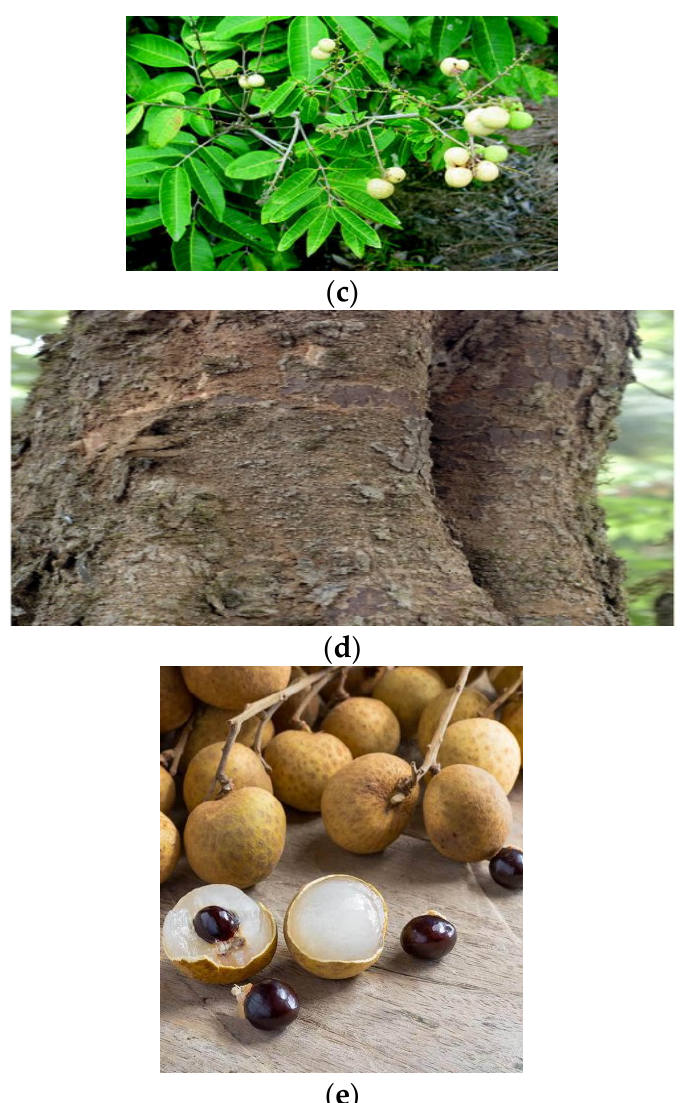
Figure 1. Diverse parts of the D. longan plant, namely, ( a ) complete fruits, ( b ) flowers, ( c ) leaves, ( d ) trunk, and ( e ) seeds.